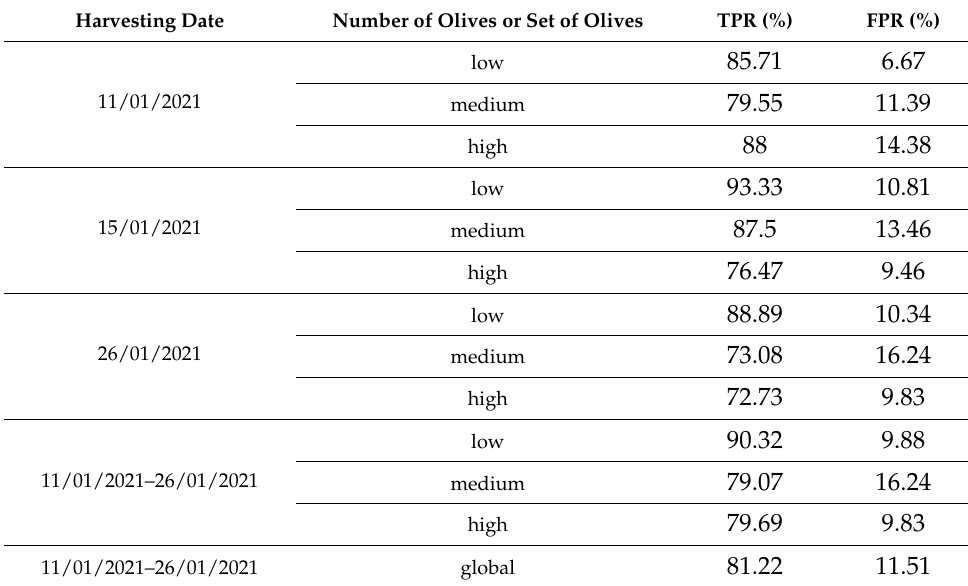
Table 1. Performance of the image processing algorithm calculated by comparison between the automated and manual inspections (ground-truth). Results are expressed in terms of True Positive Rate (TPR) and False Positive Rate